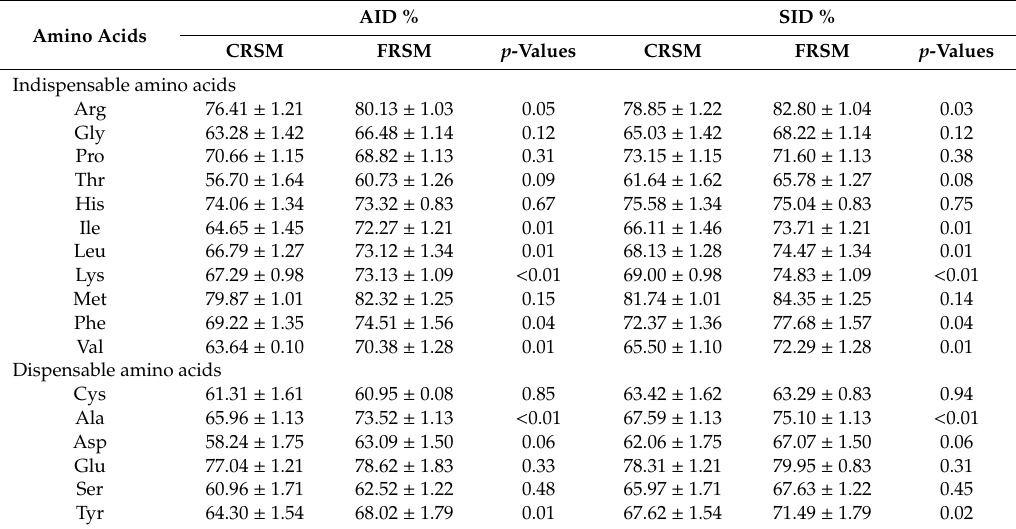
Table 8. Measure values of AID and SID for amino acids in RSM and FRSM (%, dry matter basis). AID Amino Acids